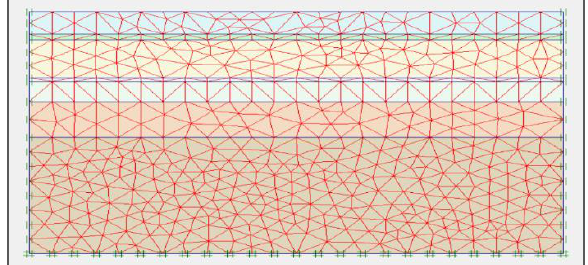
Figure 3. Numerical modelling